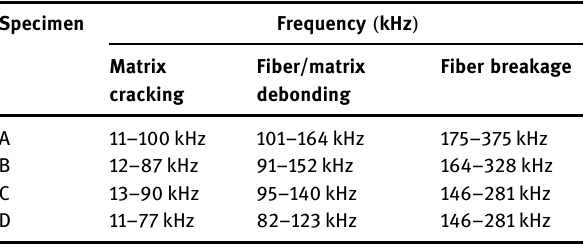
Table 3: Frequency range of four specimens with di ff erent damage modes